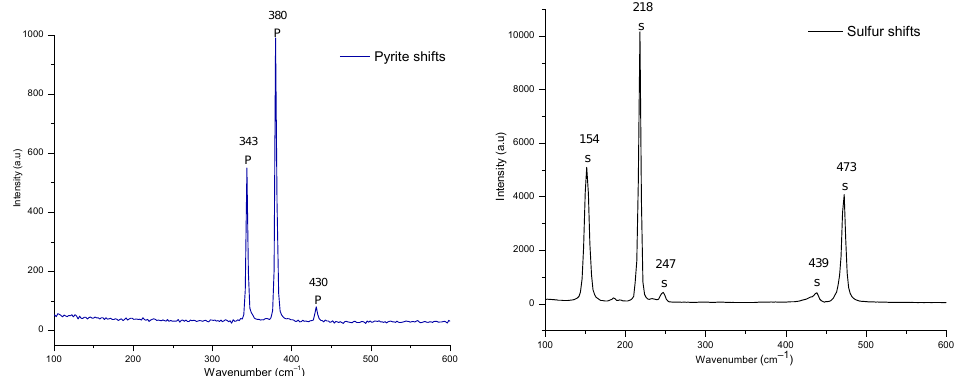
Figure 19. The Raman spectra of pyrite residue leached in 3 M nitric acid at various temperatures of 25, 45, 65, and 85 °C, showing the Raman spectra of pyrite and sulphur separately.